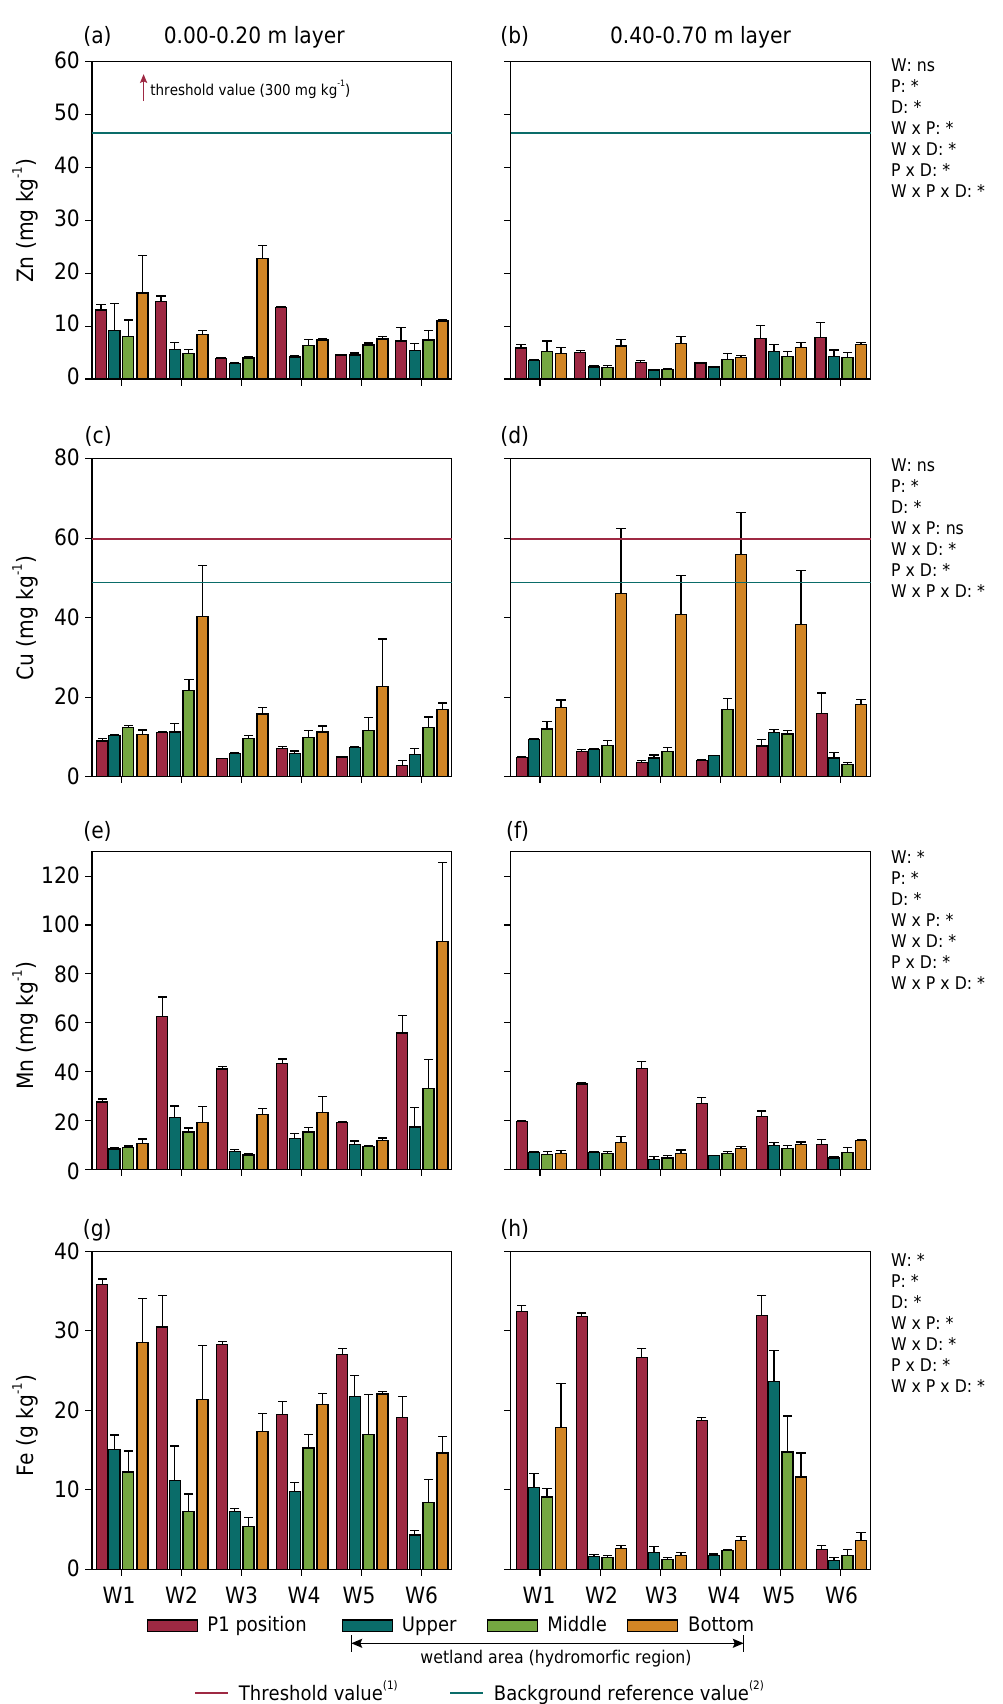
Figure 5. Zinc, Cu, Mn, and Fe contents in wetland soils of Brazilian Cerrado, Triângulo Mineiro region, Brazil. Error bars indicate the standard error (n = 3). (1) and (2) : threshold and background (or quality reference) values established by Brazilian guidelines, Minas Gerais State, Brazil (Copam Normative Deliberation